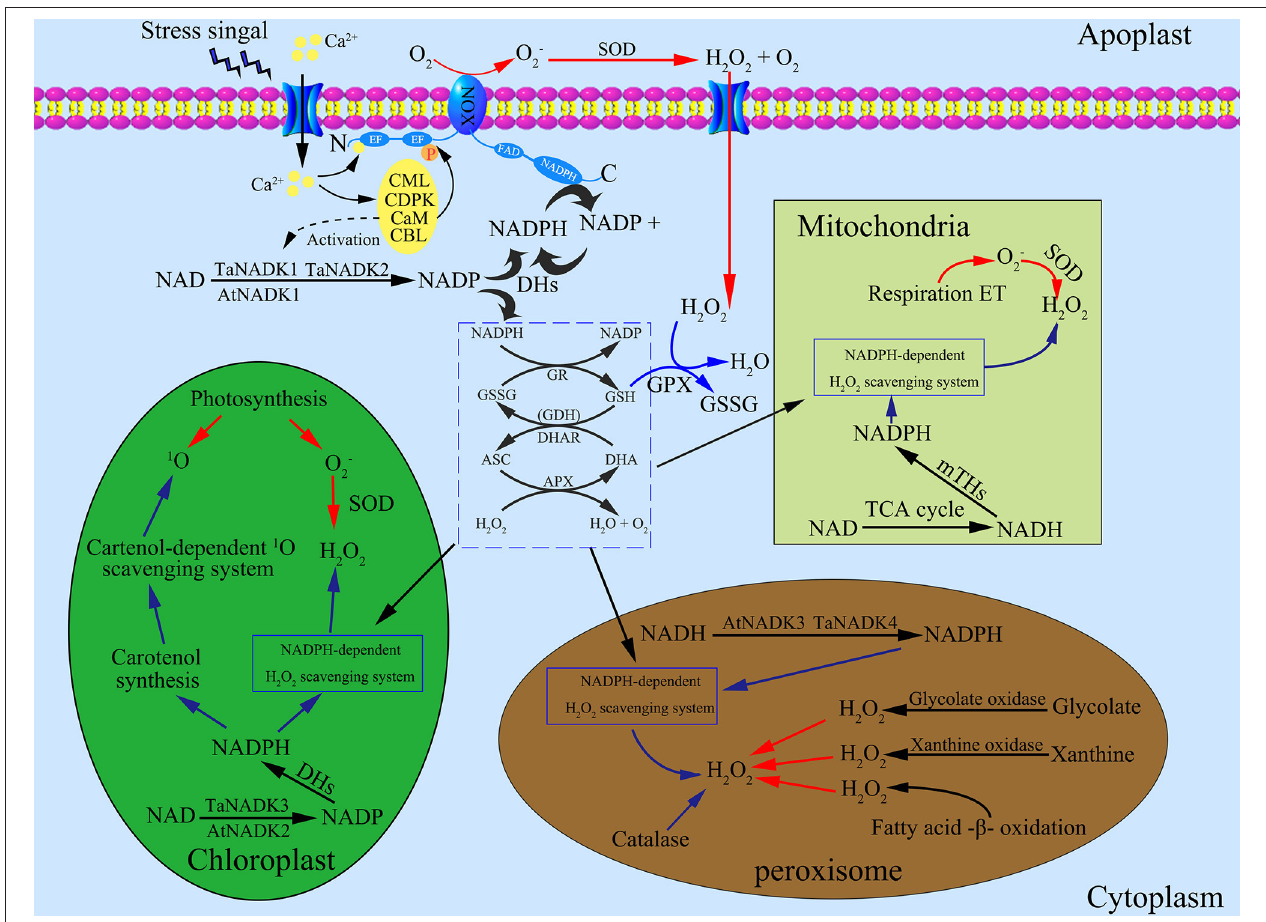
FIGURE 2 | Roles of NADK proteins in maintaining reactive oxygen species (ROS) homeostasis in different subcellular compartments of plant cells. (1) The generation of ROS in cells. NADPH oxidases (NOXs) are located on the plasma membrane which can generate superoxide radical (O − 2 ) by catalyzing NADPH. Superoxide dismutase (SOD) can transform O − 2 to oxygen and hydrogen peroxide (H 2 O 2 ), a main kind of stable ROS. The complex of Ca 2 + /CaM participate in the production of ROS by activating NOXs. Under stress conditions, intracellular Ca 2 + elevated according to Ca 2 + influx from apoplast spaces, which leads to the activation of Ca 2 + sensor proteins like the calcium-dependent protein kinase (CDPK), calmodulin (CaM), calmodulin-like protein (CML), and calcineurin B-like protein (CBL). CaMs also contribute to the activation of NADKs. In chloroplasts, photosynthesis is the main source of generating ROS: photosynthetic electron transport chain and Photosystem (PS) I or II release O − 2 , which is then transformed to H 2 O 2 by SOD. Excited chlorophylls can also generate singlet oxygen ( 1 O 2 ), a kind of ROS with high energy. In mitochondria, O − 2 is formed by the respiratory electron transport chain, which can be transformed to H 2 O 2 . In peroxisomes, H 2 O 2 is generated through three main pathways including fatty acid oxidation, xanthine oxidation and glycolate oxidation. (2) The scavenging systems of ROS in cells. As an intermediate, O − 2 can be immediately transformed to H 2 O 2 by SOD, therefore, H 2 O 2 becomes the main object of the ROS scavenging systems. The ascorbate-glutathione cycle and related enzymes including glutathione reductase (GR), dehydroascorbate reductase (DHAR), glutathione dehydrogenase (GDH) and ascorbate peroxidases (APX) function in both cytosol and other subcellular compartments such as in chloroplasts, mitochondria and peroxisomes. Besides, glutathione peroxidase (GPX) and catalase (CAT) can also detoxify H 2 O 2 . In the ROS scavenging systems, reducing power from the photosynthetic apparatus and NADPH are needed to support the operation. (3) NADKs distribute in different subcellular compartments, where they play an important role in the NADPH supply system. Firstly, NADKs can phosphorylate NAD to NADP in the different subcellular compartments. Then, dehydrogenases including glucose-6-phosphate dehydrogenase (G6PDH), 6-phosphogluconate dehydrogenase (6GPDH), NADP-dependent isocitrate dehydrogenase (ICDH), NADP-dependent malic enzyme (ME), NADP-dependent aldehyde dehydrogenase (ALDH) and NADP-dependent glutamate dehydrogenase (NADP–GDH) can transform NADP to NADPH. Transhydrogenases in mitochondria can also generate NADPH by transferring the hydrogen ion from NADH to NADP. Red arrows and blue arrows indicate the ROS generation and scavenging pathways, respectively. ASC, ascorbate; APX, ascorbate peroxidases; CAT, catalase; DHA, dehydroascorbate; DHAR, dehydroascorbate reductase; GR, glutathione reductase; GSH, glutathione; GSSG, oxidized glutathione; GDH, glutathione dehydrogenase; ROS, reactive oxygen species.